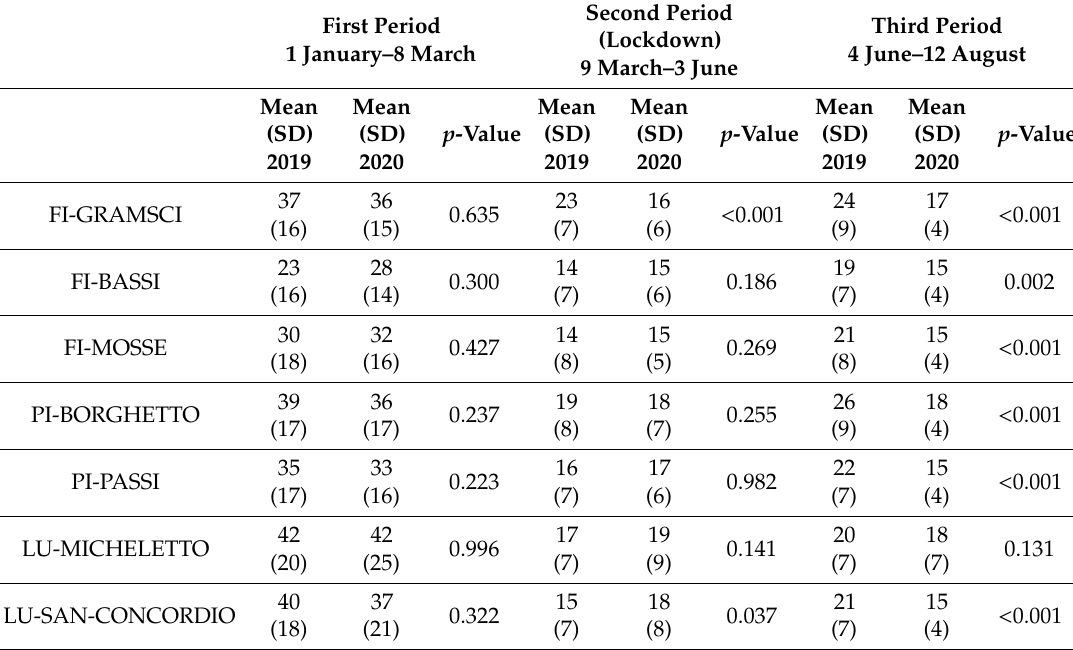
Table 2. Output of the two-sample t-test to evaluate the lockdown e ff ects on PM10 air concentration. The PM10 values are expressed in µ g · m − 3